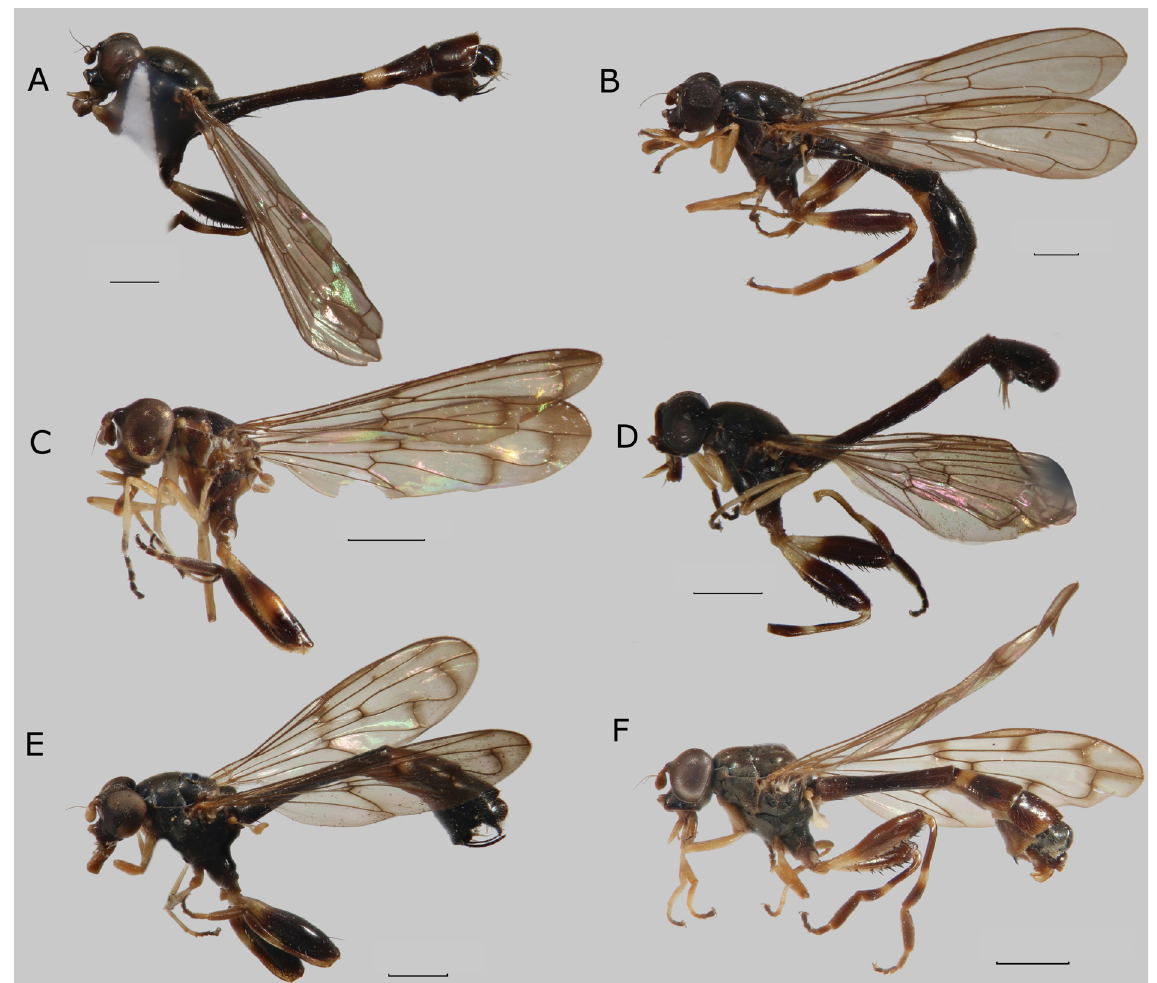
Fig. 41. Habitus, lateral view. A . Sphegina (Asiosphegina) gigantea sp. nov., holotype, ♂ ,